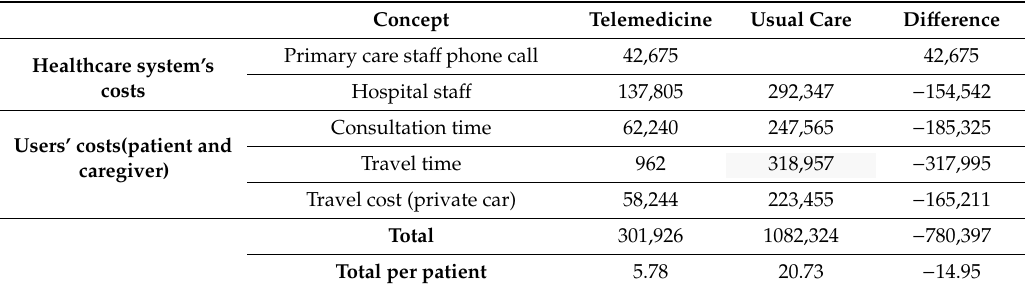
Table 4. Di ff erential costs between telemedicine and usual care (in € ).